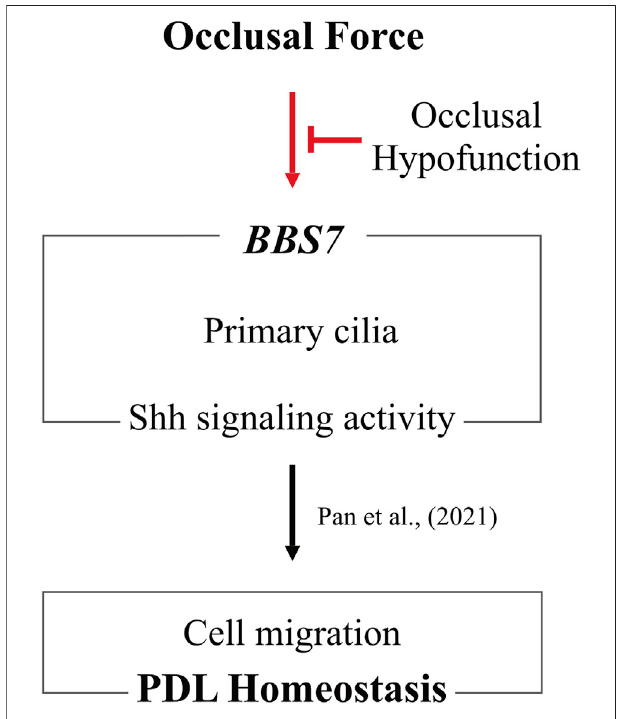
FIGURE 5 | Occlusal hypofunction affects PDL homeostasis through downregulating BBS7 . Maintenance of BBS7 expression with Shh signaling activityinprimaryciliaisoffundamentalimportancebyocclusalforce.Occlusal hypofunctioniscloselyassociatedwiththeserelationships.Furthermore, to sustain PDL homeostasis, proper occlusal force is